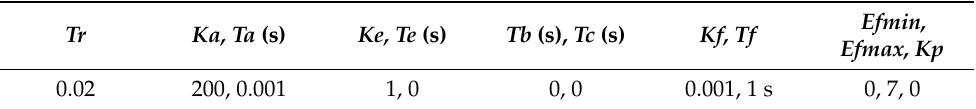
Table A2. Exciter parameters [29].